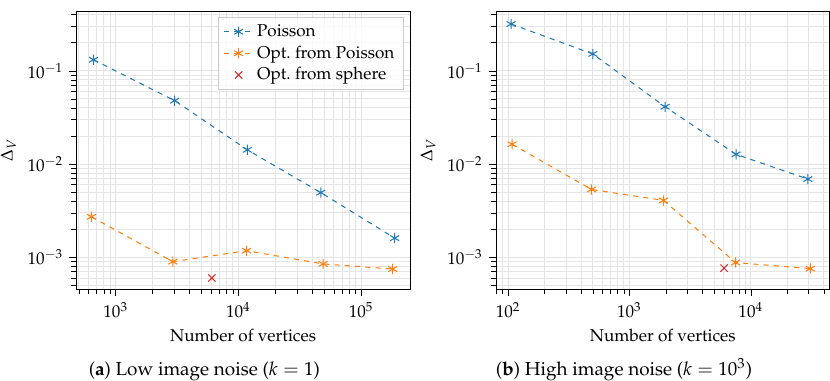
Figure 6. Comparison showing ∆ V as a function of the number of vertices in the mesh for reconstructions of a box with a cylinder. Poisson is the Poisson reconstruction, where only the connected component with the largest volume has been kept, as the Poisson reconstruction sometimes produces multiple connected components for high levels of noise. Opt. from Poisson and from sphere presents our method using the initial guesses described in Section 3.3. The Poisson reconstruction was done for spatial octree depths of 4 to 8.